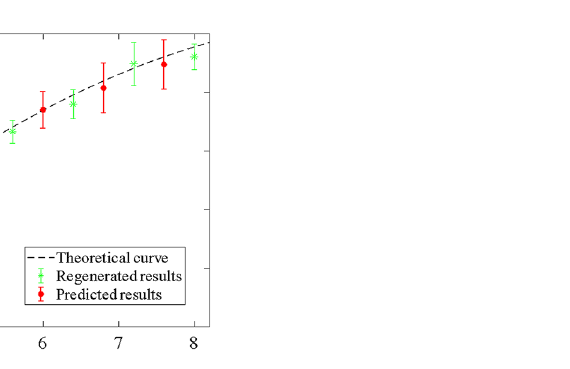
Figure 6. The fraction of the secondary phase of the regenerated and predicted SEM micrographs using RCWGAN-GP. The RCWGAN-GP-predicted the secondary phase fraction fits the JMA equation very